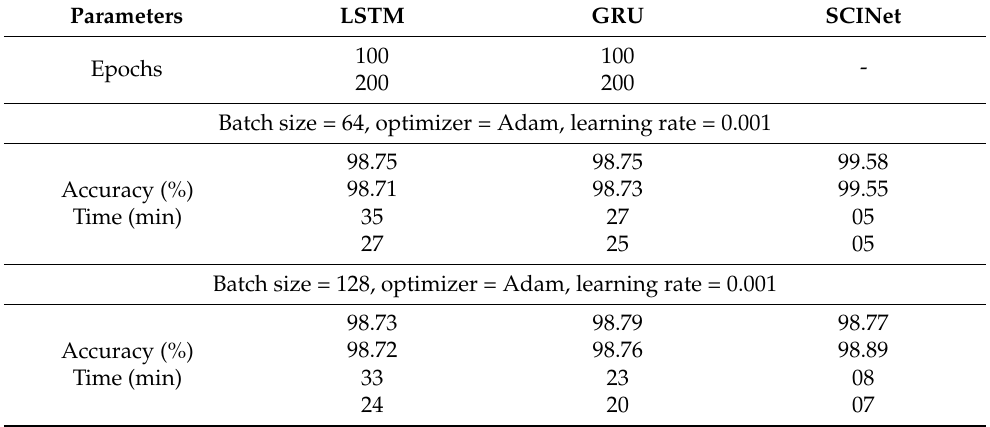
Table 5. Simulation of hyperparameters using Bayesian optimizer.